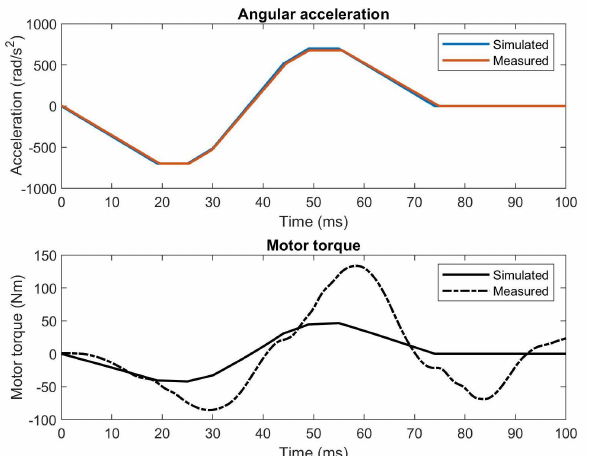
Figure 16. Comparison of the angular acceleration and the motor torque of the measurements and the simulations for a motion with a peak transverse tip acceleration of just over 21